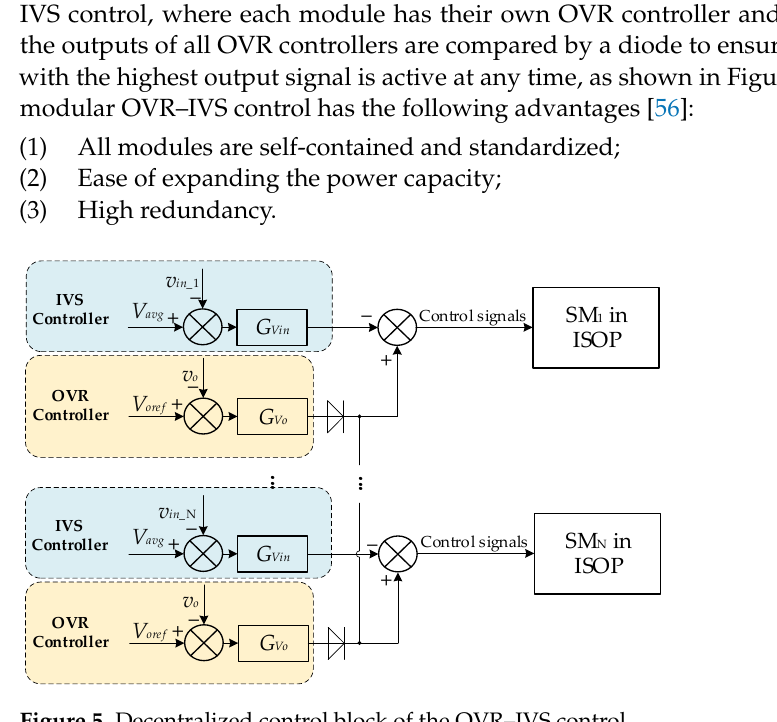
Figure 4. The master–slave control strategies for ISOP: ( a ) OVR–IVS control block and ( b ) OVR– IVS–OCS control block.